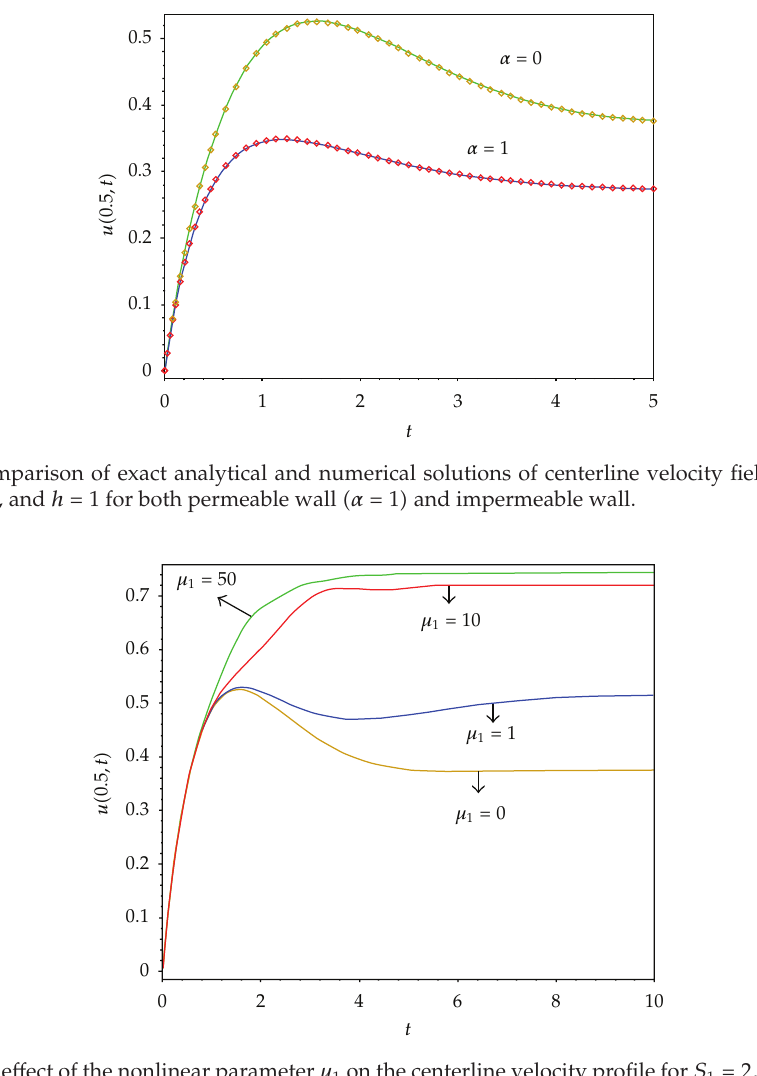
Figure 2: The e ff ect of the nonlinear parameter μ 1 on the centerline velocity profile for S 1 (cid:8) 2, S 2 (cid:8) 1, α (cid:8) 0, and h (cid:8)